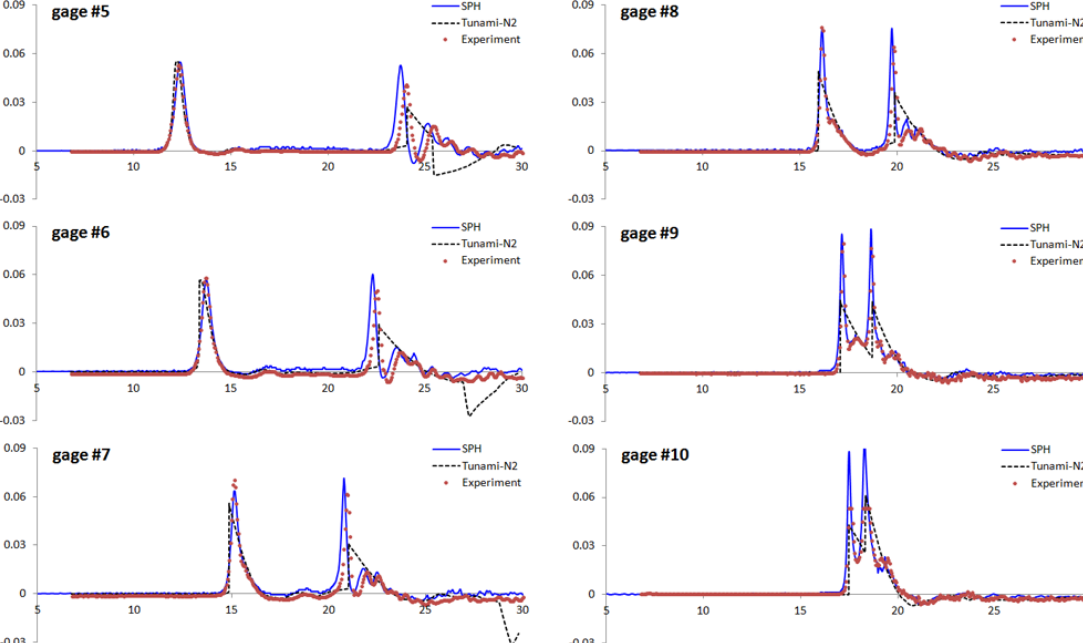
Fig. 7. Comparisons of time histories of wave height obtained from the experiment and numerical simulations at gages 5–10 of case